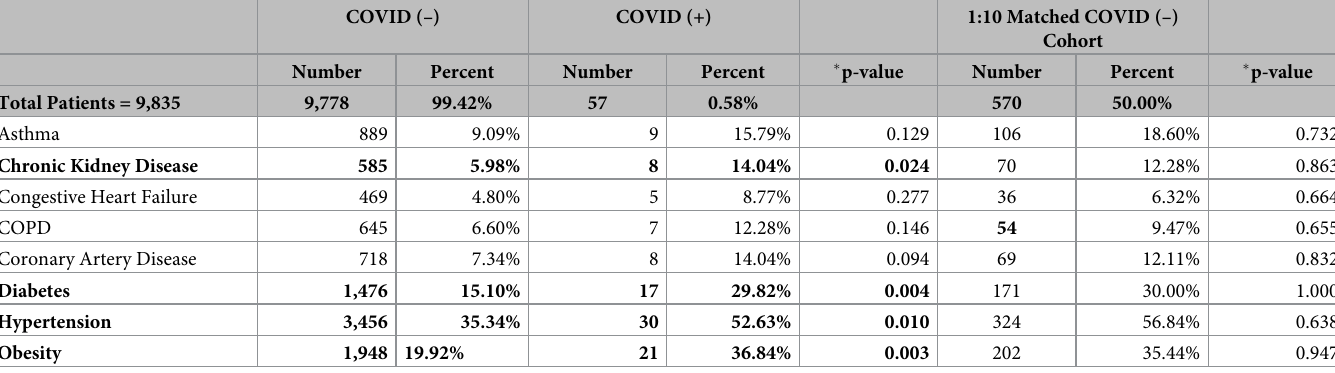
A 1:10 COVID-negative cohort was constructed and propensity matched on the basis of age, sex, and comorbidities for comparison to the COVID-positive cohort. After propensity matching, no statistically significant differences between demographic or comorbidity factors were noted between the COVID-positive and negative groups (Tables 1 and 2).